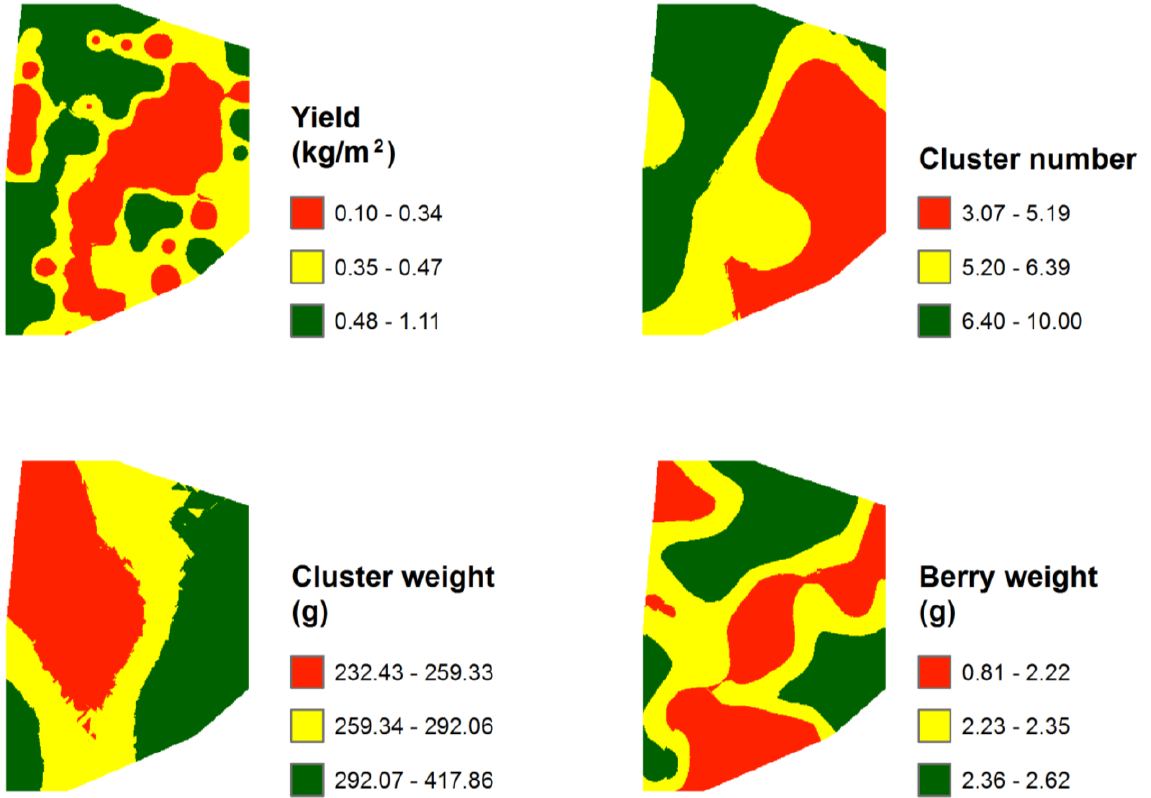
Figure 5. Maps obtained for yield parameters (cluster number per vine, cluster weight, yield per vine, and berry weight) in a Tempranillo ( Vitis vinifera L.) vineyard. Maps were represented by